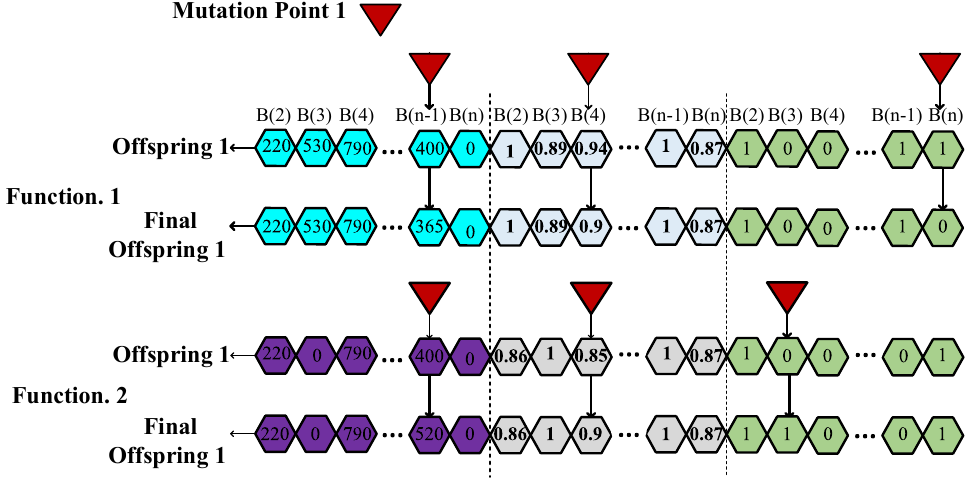
Figure 5. Chromosomes used in the GA algorithm.